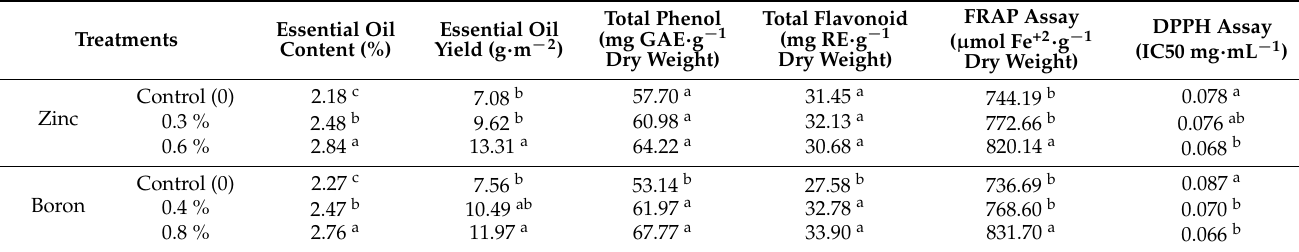
Table 7. Mean comparison of the simple effects of boron and zinc foliar application on phytochemical traits of S. khuzistanica in the second year of the